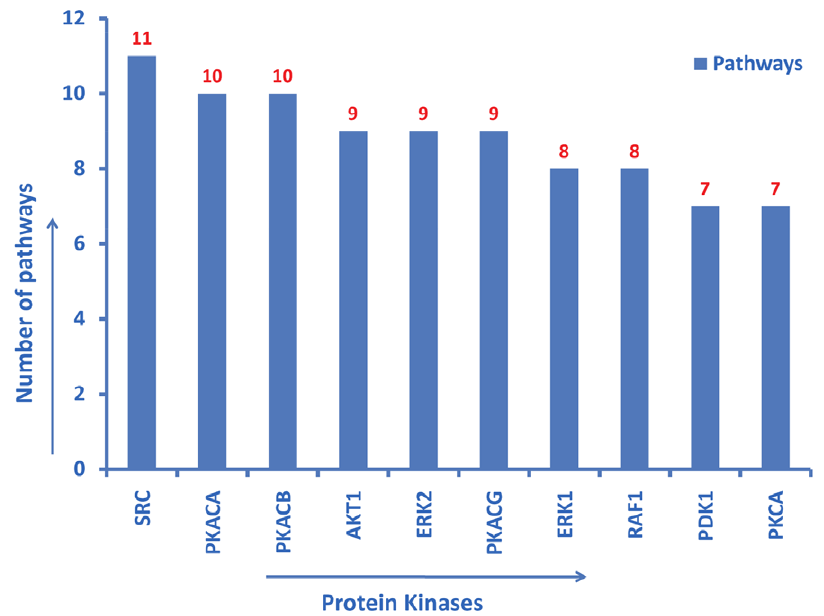
Figure 4. Counts of number of pathways associated with all protein kinases. Top 10 kinases with the most number of pathways are displayed in descending order. The SPARQL query to generate this figure can be directly viewed and excuted from the ProKinO browser by selecting ‘‘Query 3’’ under the ‘‘Example queries’’ tab in the main page.